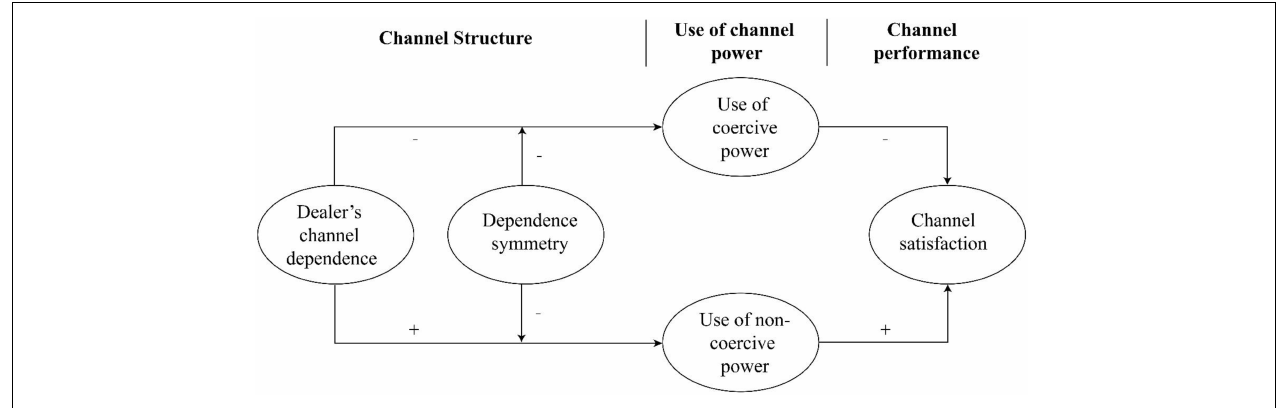
FIGURE 1 | Research